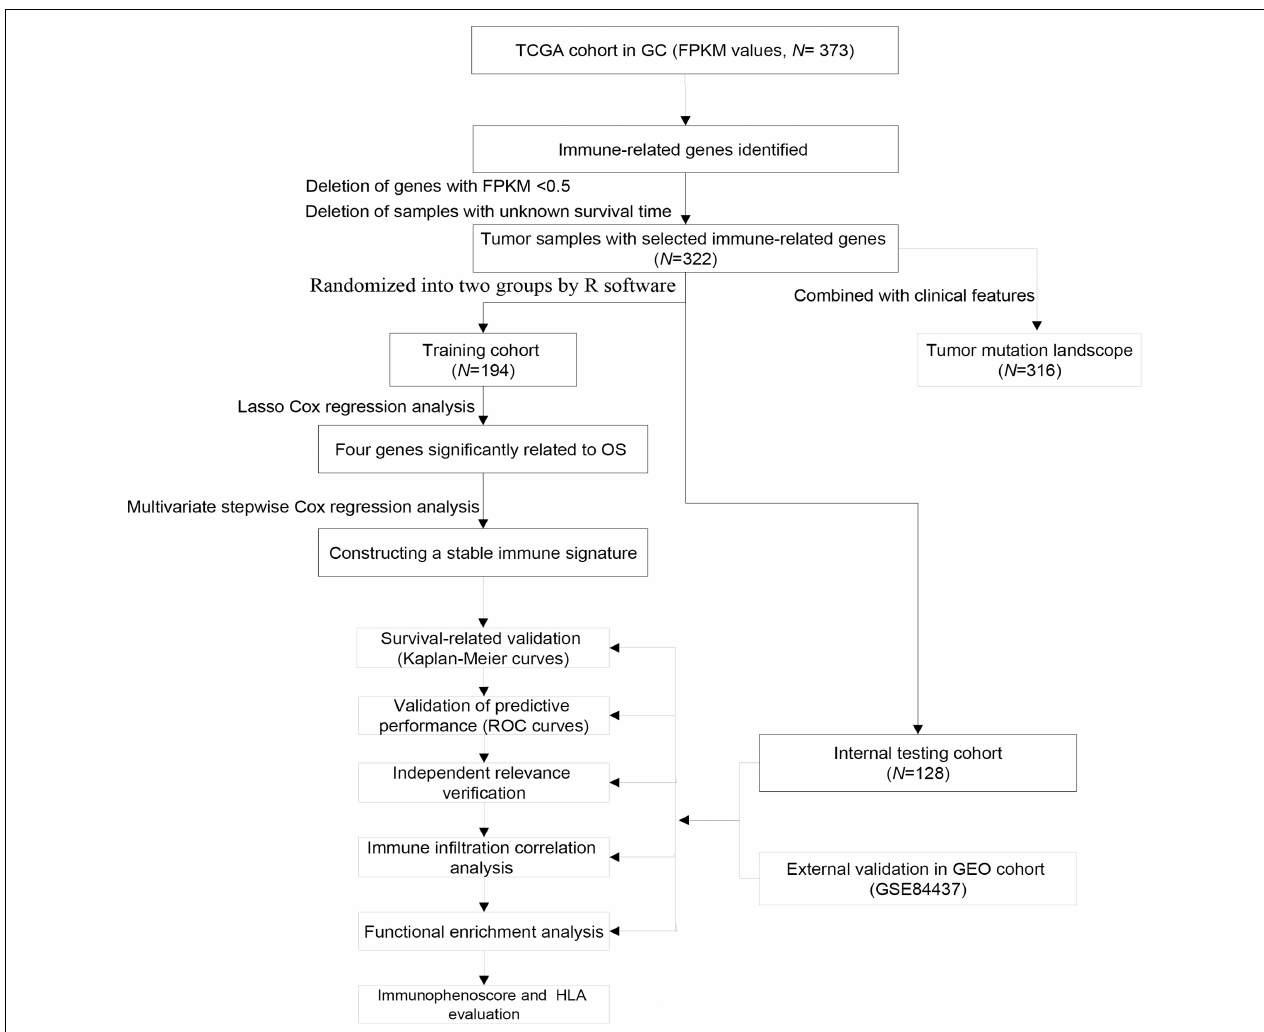
FIGURE 1 | Flowchart of the